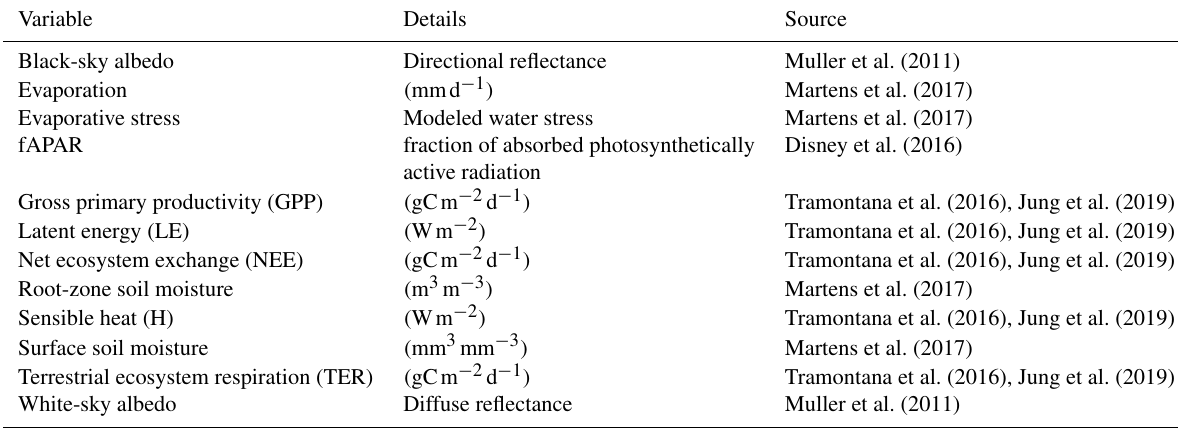
Table 1. Variables used describing the biosphere. For a description of the variables, see Appendix A.